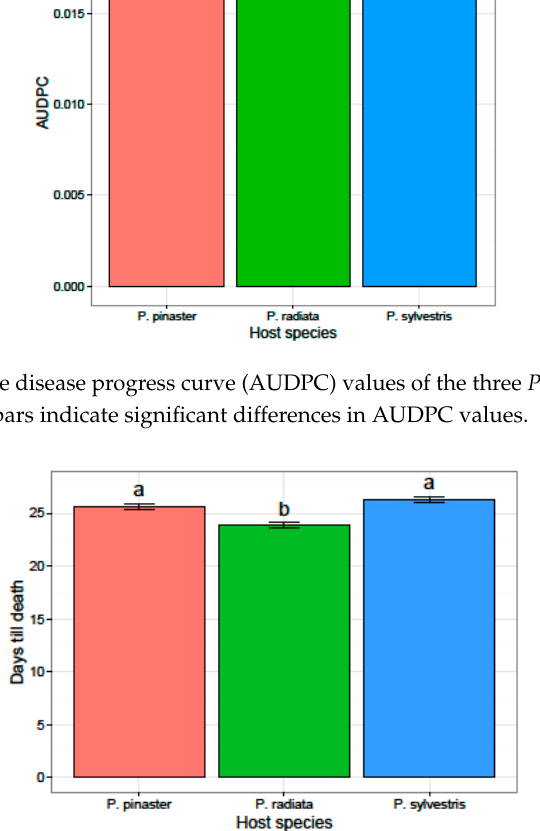
Figure 3. Days till death of the three Pinus species inoculated. Different letters above bars indicate significant differences in days till death.